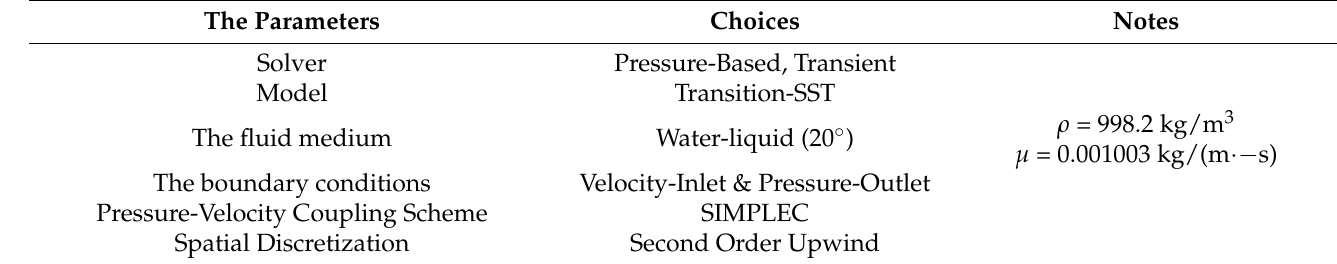
Table 5. The input